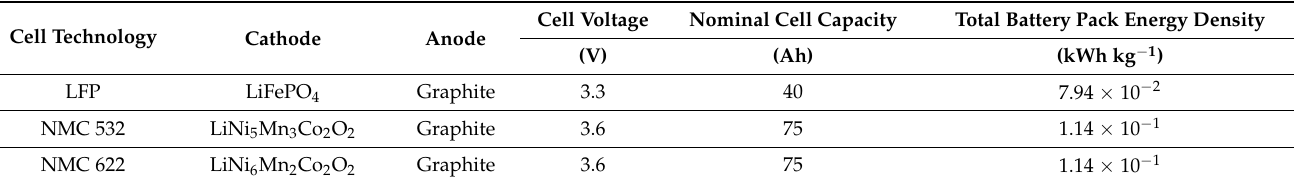
Table 1. Electrochemical characteristics and performance of the three analyzed stationary batteries. Cell Voltage Nominal Cell Capacity Total Battery Pack Energy Density Cell Technology Cathode Anode (V) (Ah) (kWh kg − 1 ) LFP LiFePO 4 Graphite 3.3 NMC